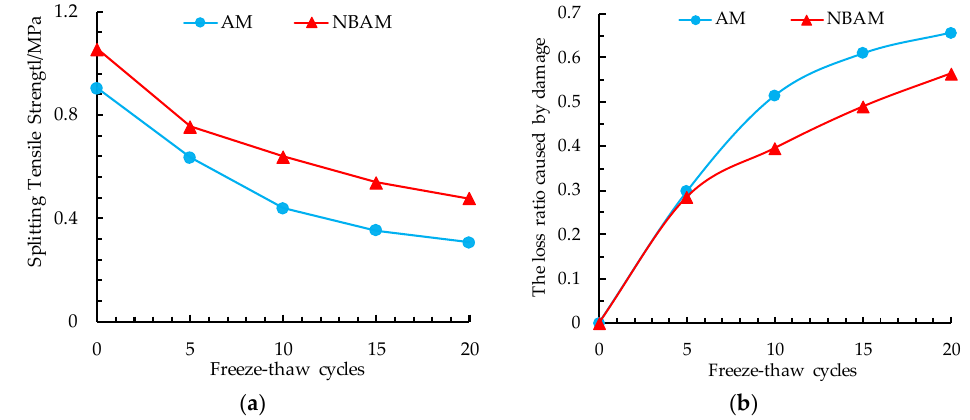
Figure 10. Relationship between splitting tensile strength and freeze‒thaw cycles: ( a ) splitting tensile strength trend chart; ( b ) loss ratio of splitting tensile strength caused by damage.